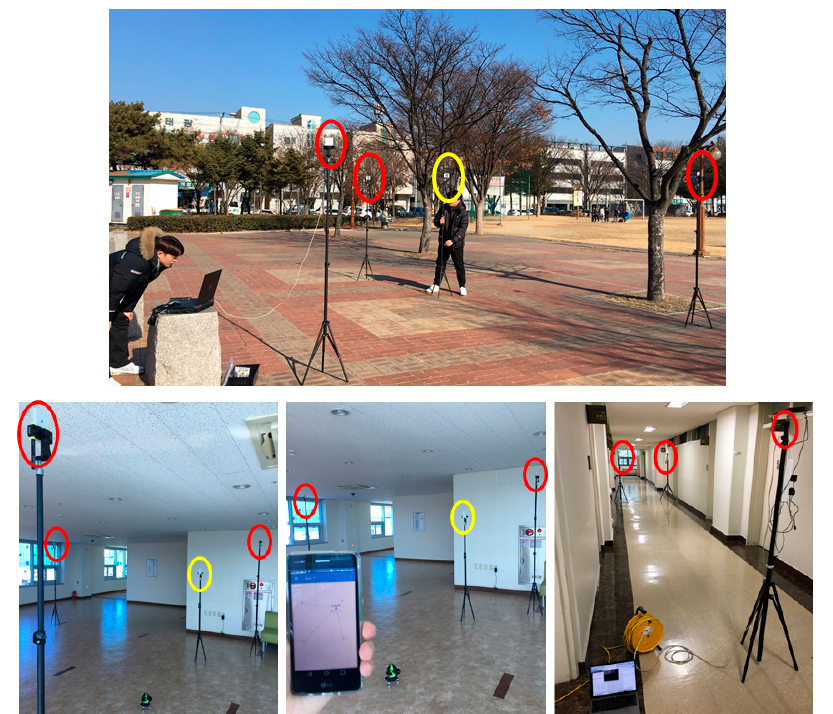
Figure 5. Communication test in indoor and outdoor spaces with a tag (yellow circle) and 3 anchors (red circles).